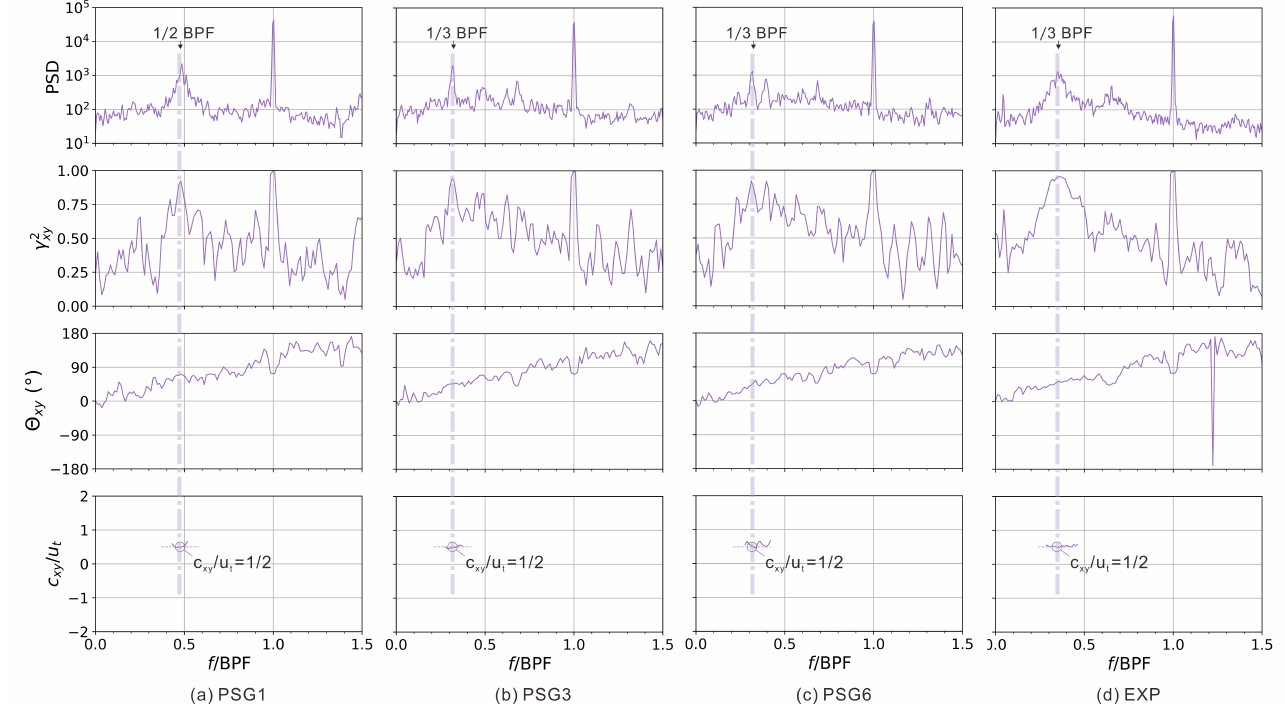
Figure 7. Spectral analysis of the wall pressure in the stationary reference frame for s / C = 4.3% at Φ =